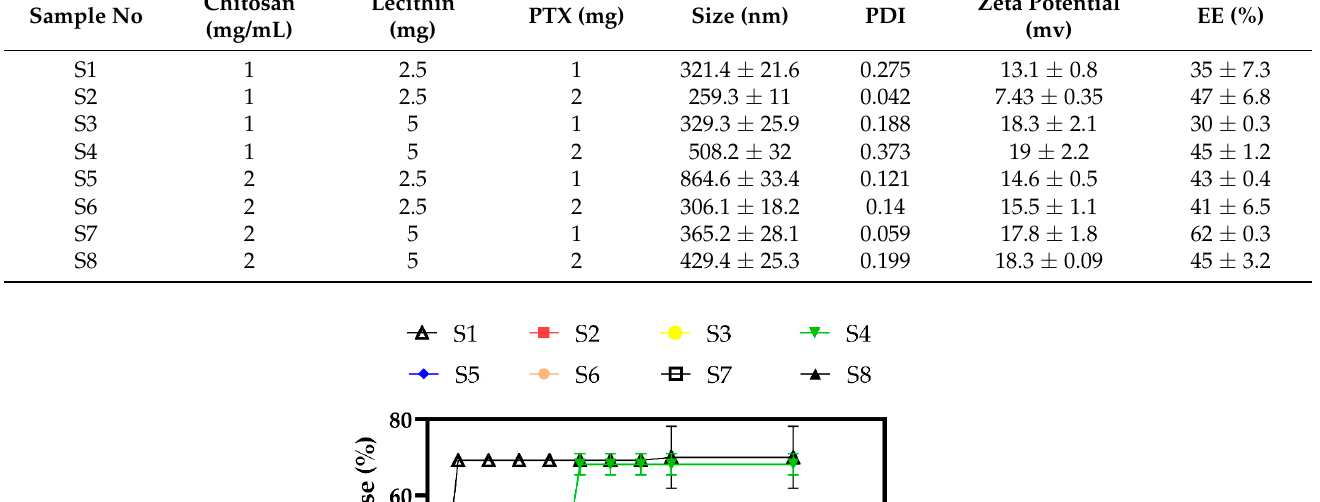
Table 1. The amount of chitosan, lecithin, and PTX in the developed nanoparticles, as well as properties of the developed nanoparticles, including size, polydispersity index, zeta potential, and drug entrapment efficiency.